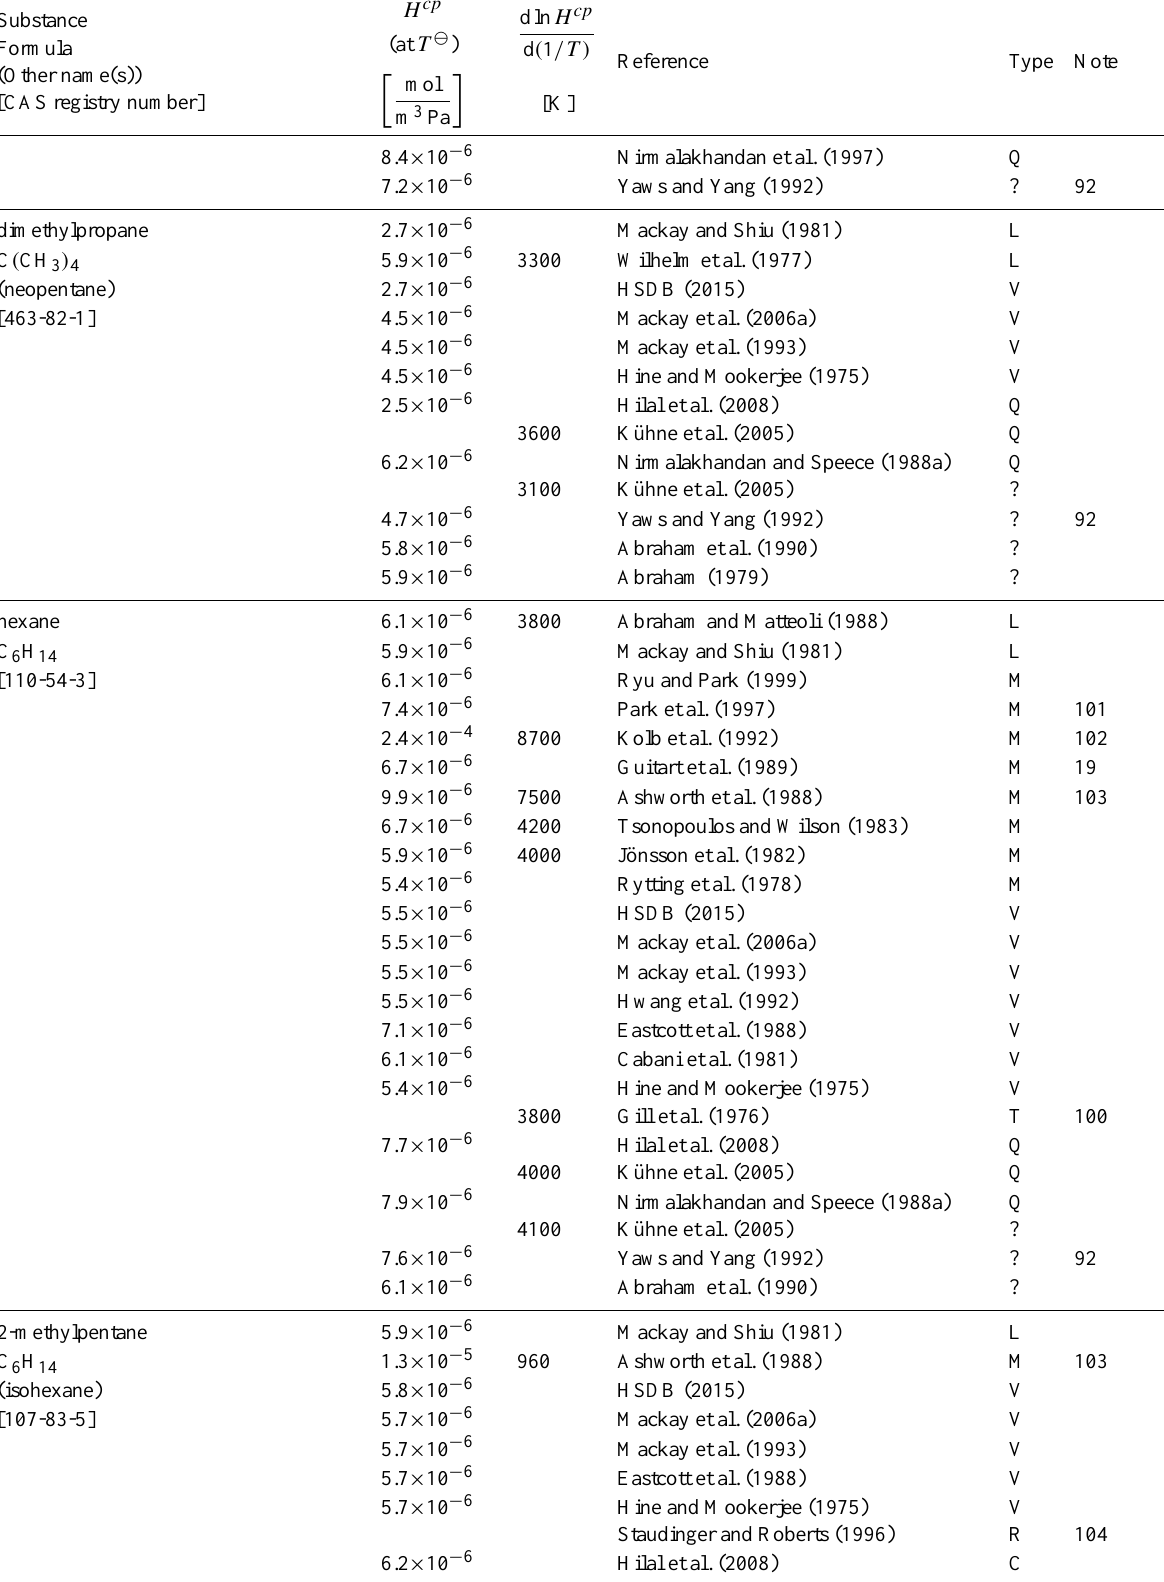
Table 6: Henry’s law constants for water as solvent